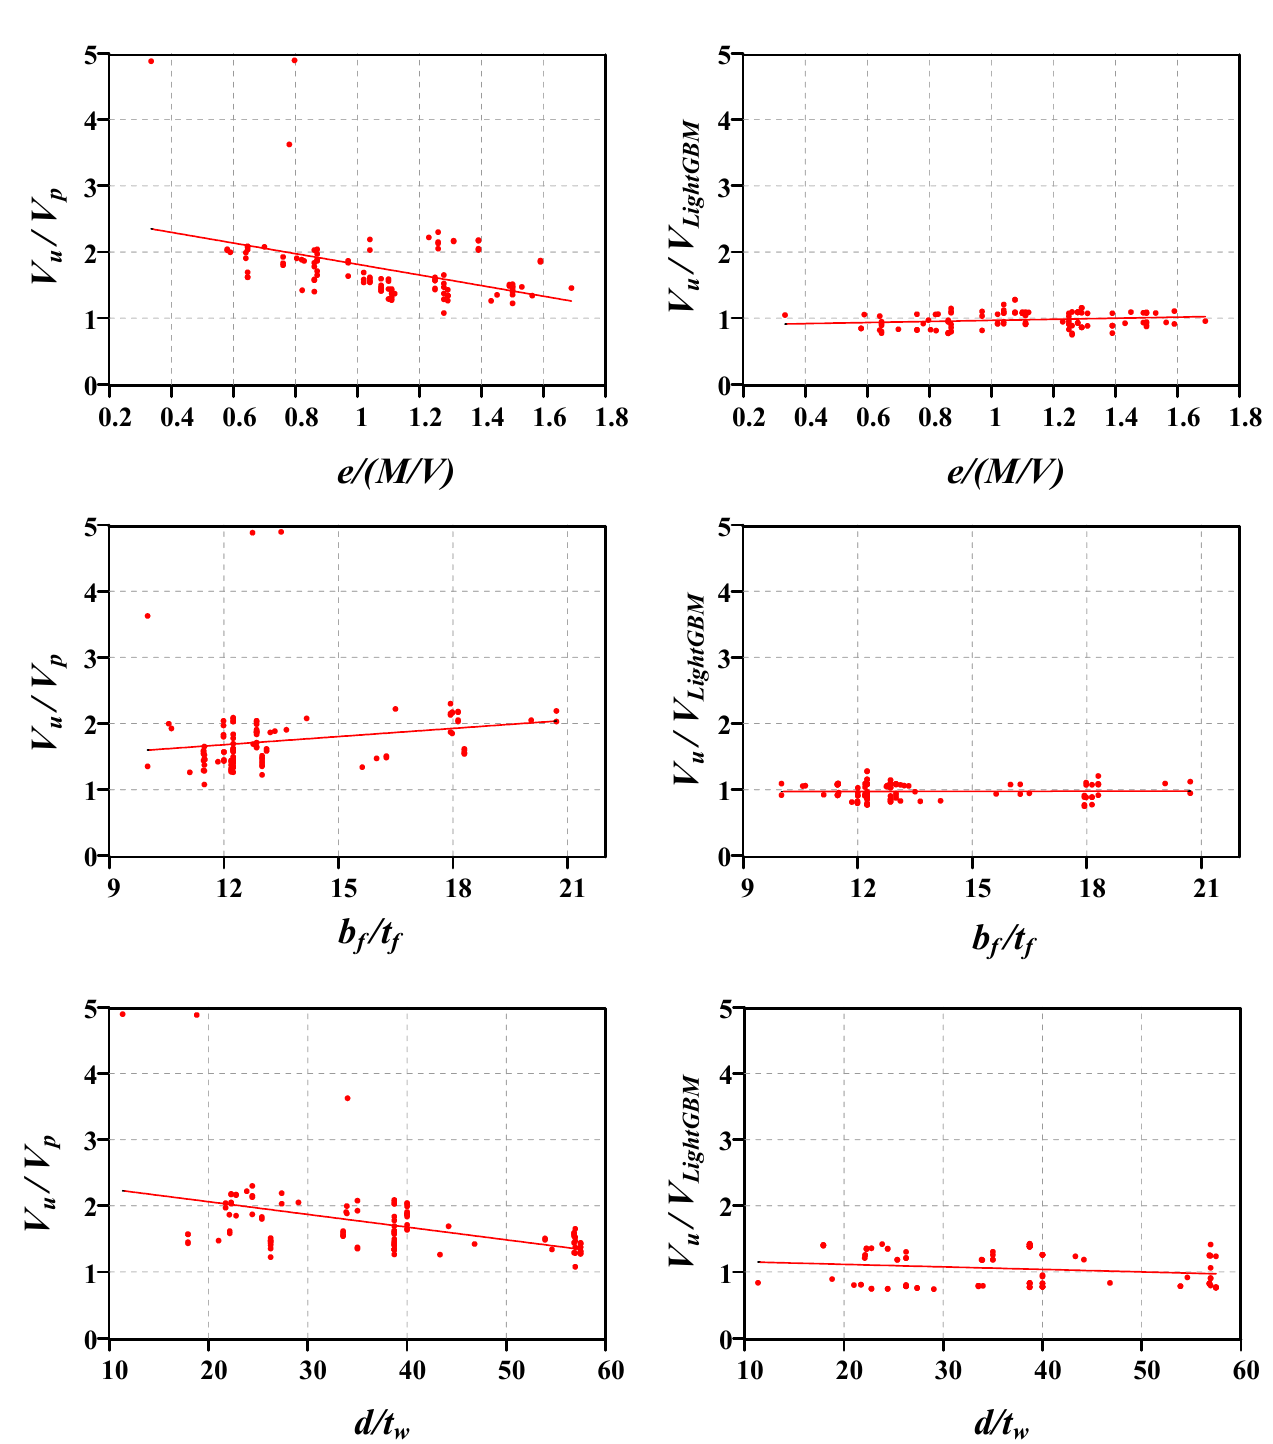
Figure 10. Distribution of overstrength ratio for the built-up sections.